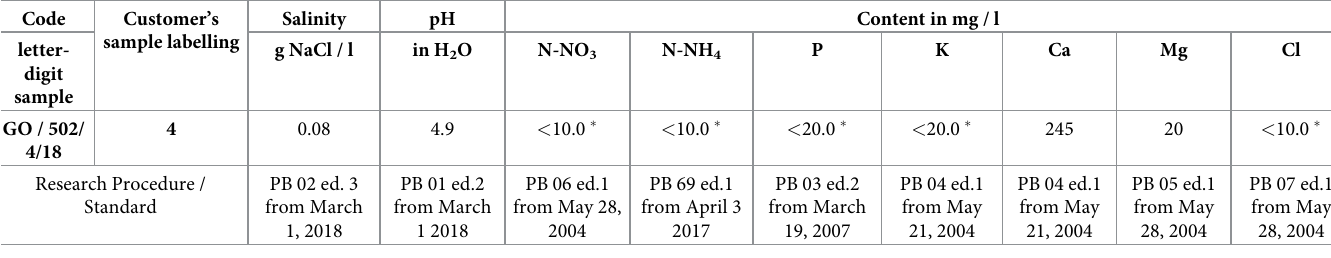
Table 1. Test report no. GO /